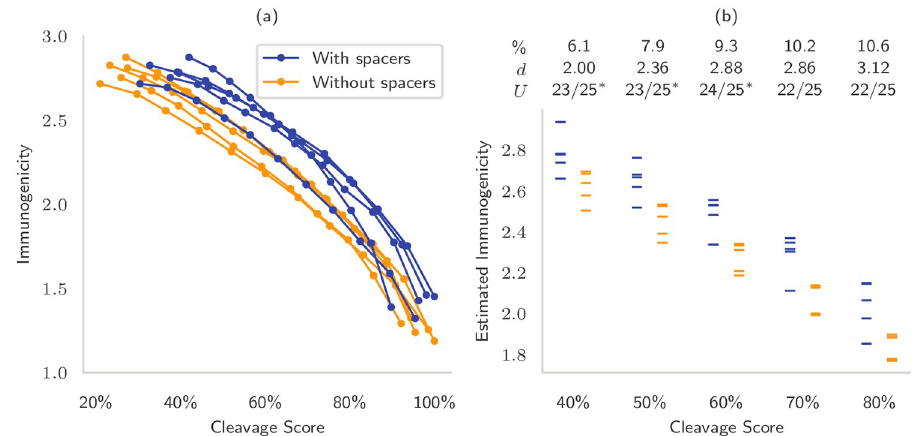
Fig 3. Novel EV design possibilities obtainable by considering epitope selection and epitope assembly at the same time. (a) We created five bootstraps of protein sequences and generated string-of-beads vaccines on the Pareto frontier by maximizing immunogenicity and cleavage score at the same time. The epitopes were either joined directly (yellow) or by optimal spacer sequences (blue). The cleavage score of the two groups was normalized separately to allow comparisons between spacers and direct links. (b) We selected five percentiles of the cleavage score, from 40 to 80 of the global maximum, and estimated the immunogenicity that can be obtained via linear interpolation between the closest points on the Pareto frontier of each bootstrap. The table above shows the percent increase in immunogenicity relative to the no-spacers group, the effect size d computed as the difference of the means normalized by the standard deviation of the no-spacers group, and the Mann-Whitney U test statistic, that shows the number of pairwise comparisons that were favorable for the designed spacers ( � for p < 0.05).